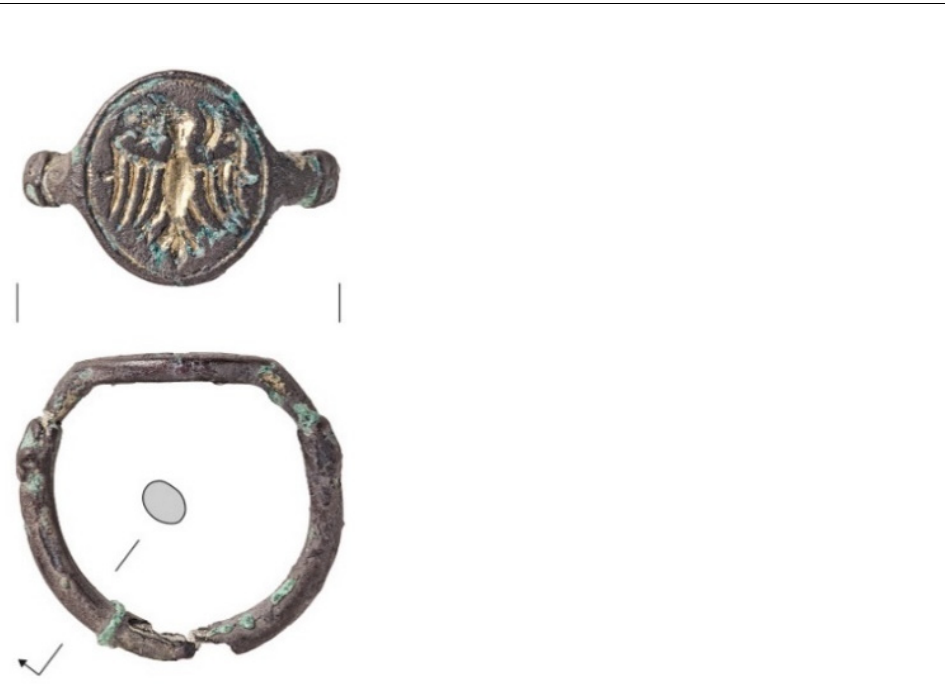
Figure 4. Treasure from Wiener Neustadt. Finger ring with “eagle” motif, 13th/14th century. Photo: Paul Kolp; editing: Franz Siegmeth.